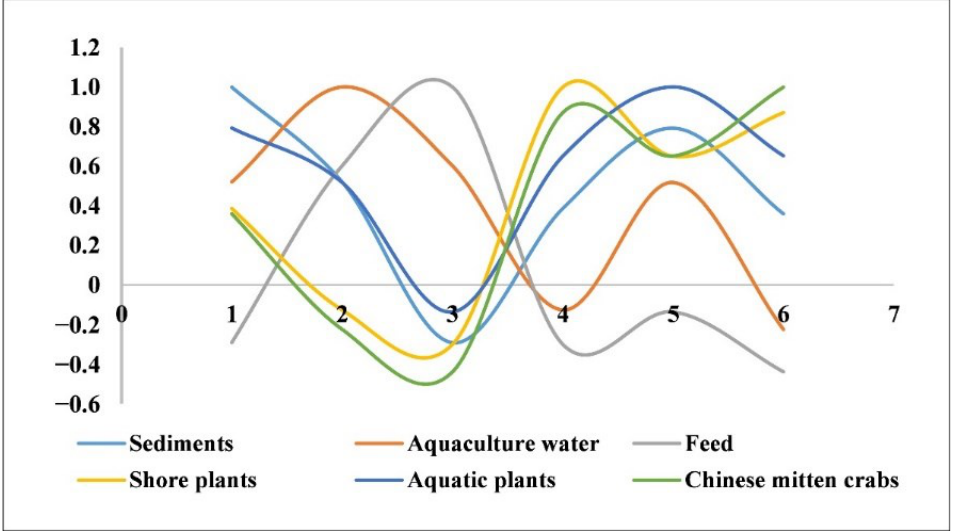
Figure 6. Correlation analysis of the residual pollutants in Chinese mitten crabs and the potential sources.